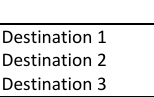
Table 6. The Standard error and IV of nested logit simultaneously Table 6.The Standard error and IV of nested logit simultaneously model SEIV